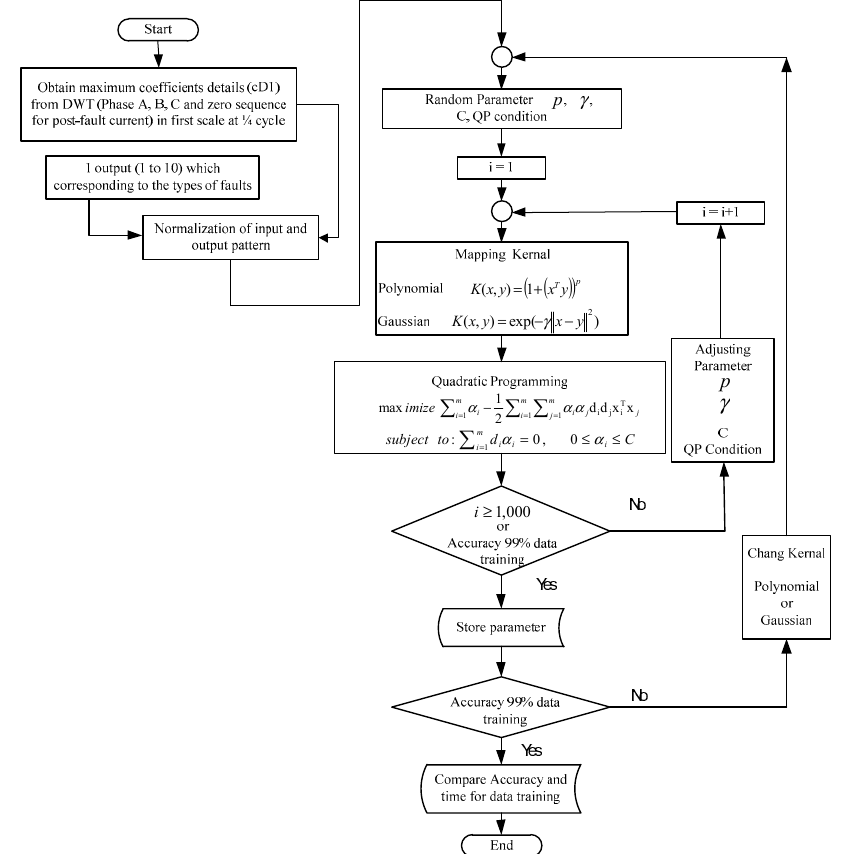
Figure 7. Training process of the support vector machine (SVM).